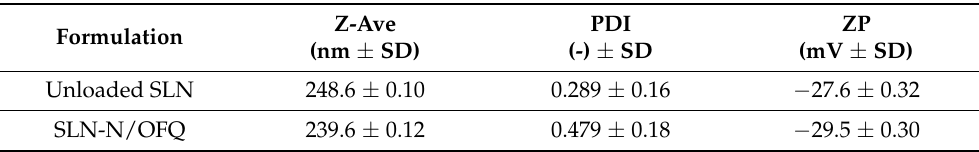
Table 1. Characterization of the SLN-N/OFQ formulation: the values of Z-Ave, PDI and ZP for unloaded and SLN-N/OFQ recorded at 20 ◦